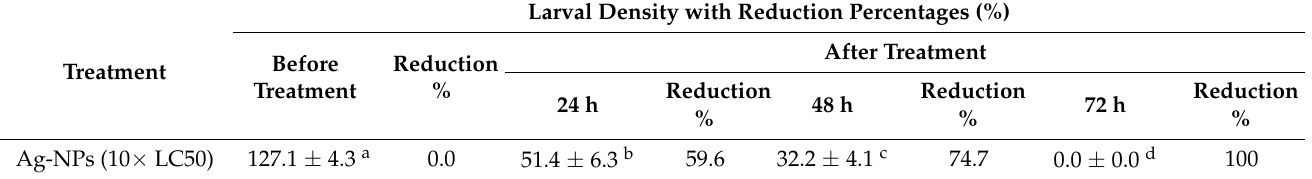
Table 2. Field assay of A. aegypti larval density with reduction percentages due to treatment with Ag-NPs (10 × LC50) fabricated by A. niger strain